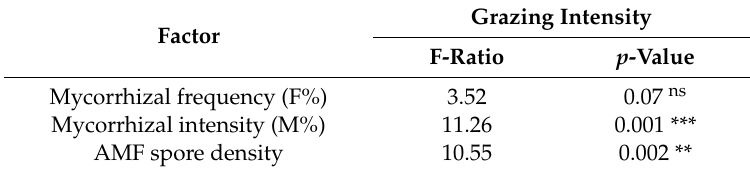
Table 3. Two-factor ANOVA analysis of the impact of grazing intensity on mycorrhizal parameters. F-Ratio Grazing Intensity Factor